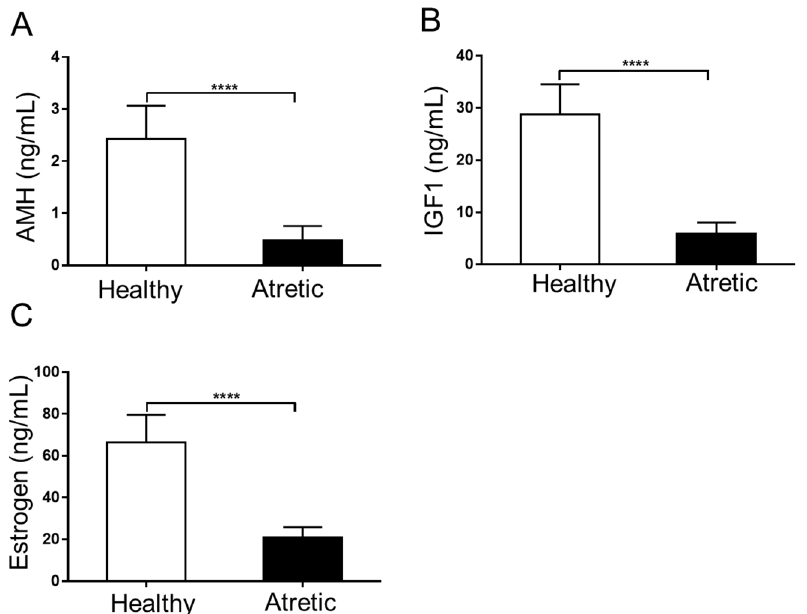
Figure 1. Hormone concentrations in pooled follicular fluid of 4–7 mm HA and AA follicles obtained from 6 different sows. ( A ) Anti-Müllerian hormone (AMH) concentrations (ng/mL). ( B ) Insulin-like growth factor 1 (IGF1) concentrations (ng/mL); ( C ) Estradiol concentrations (ng/mL). HA, healthy antral follicles; AA, atretic antral follicles. Values represent means +/- SEM. ****, p < 0.001.